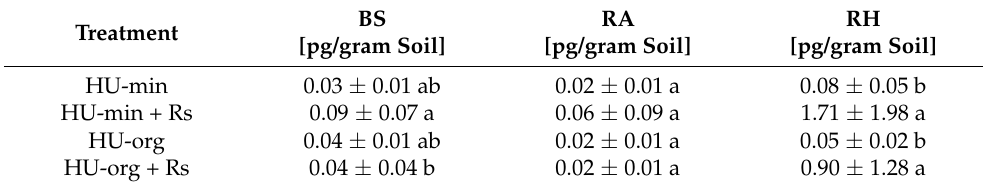
Table 7. Quantity of Rhizoctonia solani AG1-IB (in pg DNA per gram soil) in bulk soil (BS), root- associated soil (RA) and rhizosphere (RH) of lettuce (cv. Tizian) grown in soils with organic (HU-org) or mineral (HU-min) fertilization strategy in the absence and in the presence of R. solani AG1-IB (isolate 7/3/14, +Rs). Mean ± standard deviation is displayed. Different lower case characters indicate significant differences, tested separately per habitat by two-way ANOVA followed by Tukey’s test ( p <